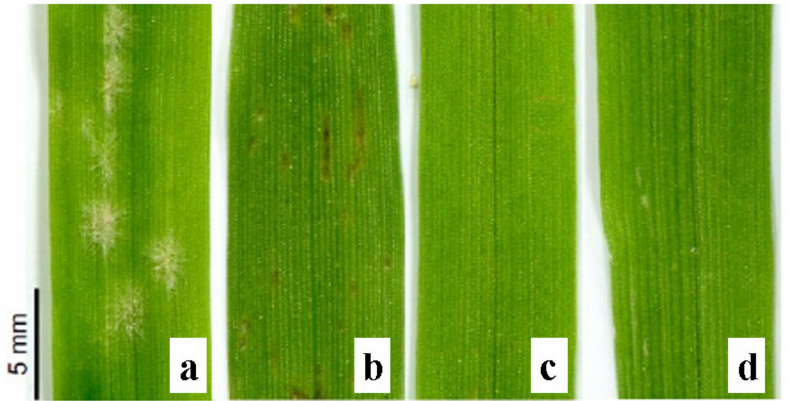
Figure 1. Barley leaves after powdery mildew inoculation at 7 days post inoculation (dpi): cultivar Ingrid with visible symptoms ( a ), as well as its near isogenic lines-Mla with visible symptoms ( b ), Mlg ( c ) and mlo ( d